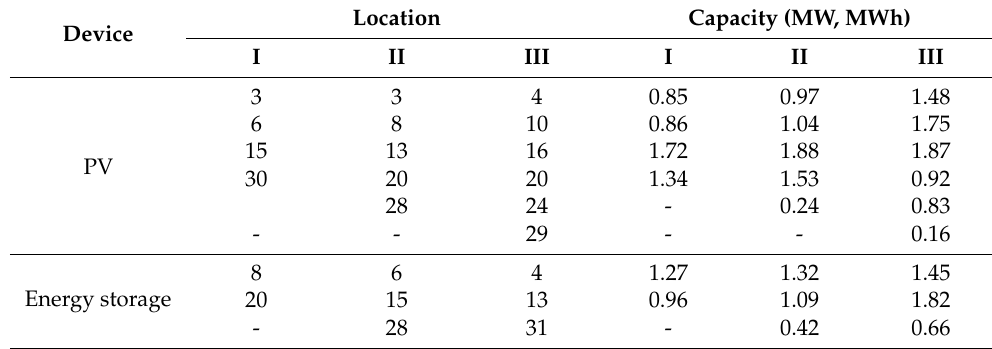
Table 4. The optimal location and capacity configuration results of PV and load in DNs.